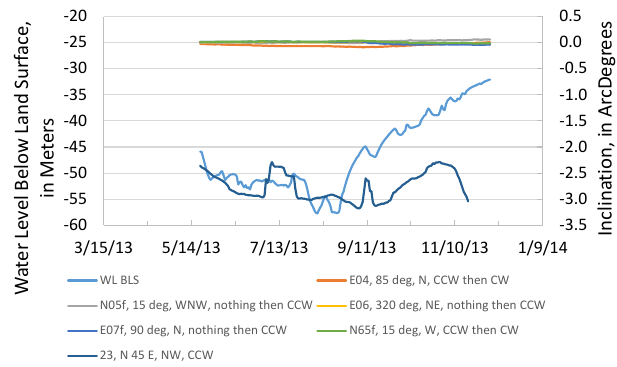
Figure 5. Biaxial tilt compared with water-level fluctuation in nearby observation well. Sensor locations are in Fig. 1. Station 23 is 100m east of the fissure. The legend gives the azimuth of the ver- tical plane of tilt, viewing direction, and sense of rotation for two segments of each graph. CW is clockwise; CCW is counterclock- wise. Deformation extends at least 100m east of the fissure zone, and tilt at Station 23 is approximately ten times greater than tilt in the fissure zone.